Question: Briefly state, in one sentence, what is plotted here.
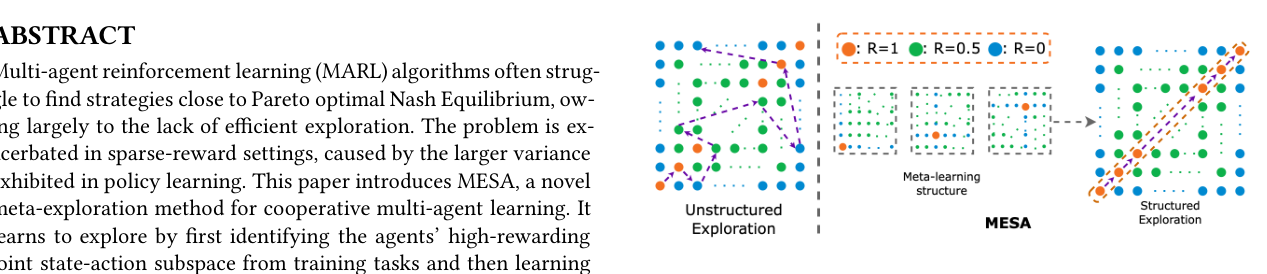
Answer: Illustration of structured exploration and unstruc- tured exploration behavior in the 2-player climb game. The rows and columns indicate the players’ action space. While unstructured exploration aims to visit novel states, structured exploration exploits structures in the joint state- action space, helping agents coordinatedly and more eﬃ- ciently explore the potential high-reward subspace.